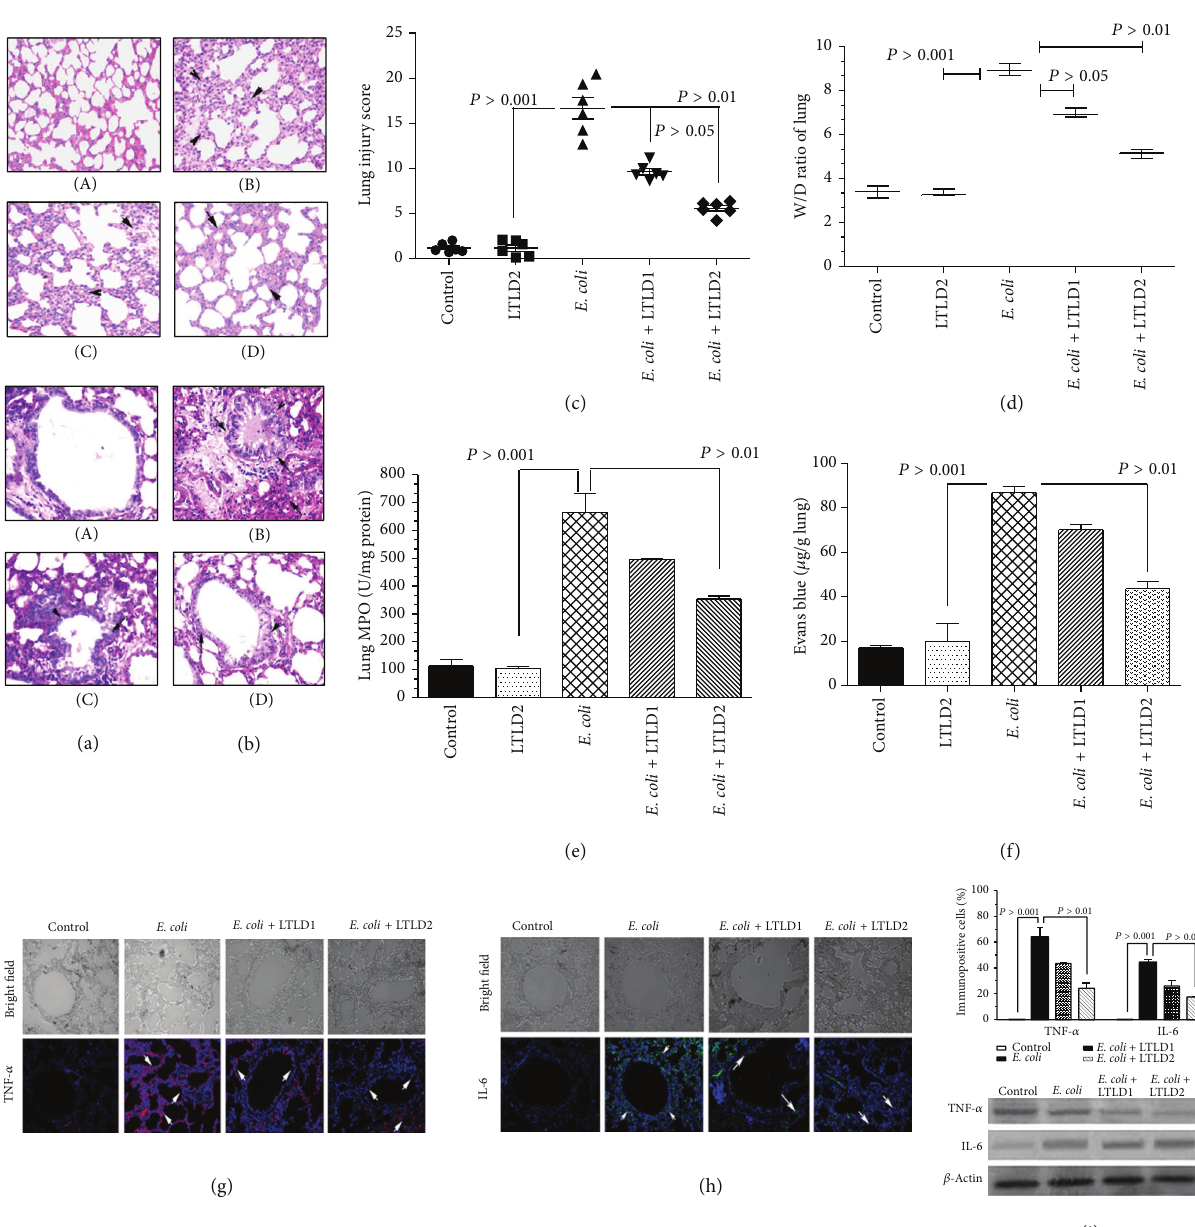
Figure 5: Effects of LTL on lung histopathological changes in heat-killed E. coli challenged mice ( 𝑛 = 10 ). Mice were administered i.p. with LTL at doses LTLD1 (25mg/kg) and LTLD2 (50 mg/kg) prior to heat-killed E. coli O18:K1, 10 4 CFU challenge. (A) Control group, (B) E. coli group, and (C) and (D) with LTL at doses LTLD1 and LTLD2. The arrows indicate infiltration generated prominent inflammatory cells and alveolar hemorrhage. Left panel (a) shows H&E staining and right panel (b) shows PAS staining, original magnification ( × 200). (c) The total lung injury score was calculated by adding up the individual scores of each category. (d) Lung W/D ratio assessment and the evaluation (e) of lung MPO activity with (f) the extravasation of parenchymal vascular leak. Localization of TNF- 𝛼 (g) and IL-6 (h) in lung tissues after E. coli challenge in mice. Magnification (200x) arrows indicate immunopositive cells. Approximately 200 cells were counted per field, five fields were examined per slide, five slides were examined per group, and data were validated by western blot analysis (i). Values are presented as mean ± S.E.M. ( ∗ 𝑃 < 0.05 , ∗∗ 𝑃 < 0.01